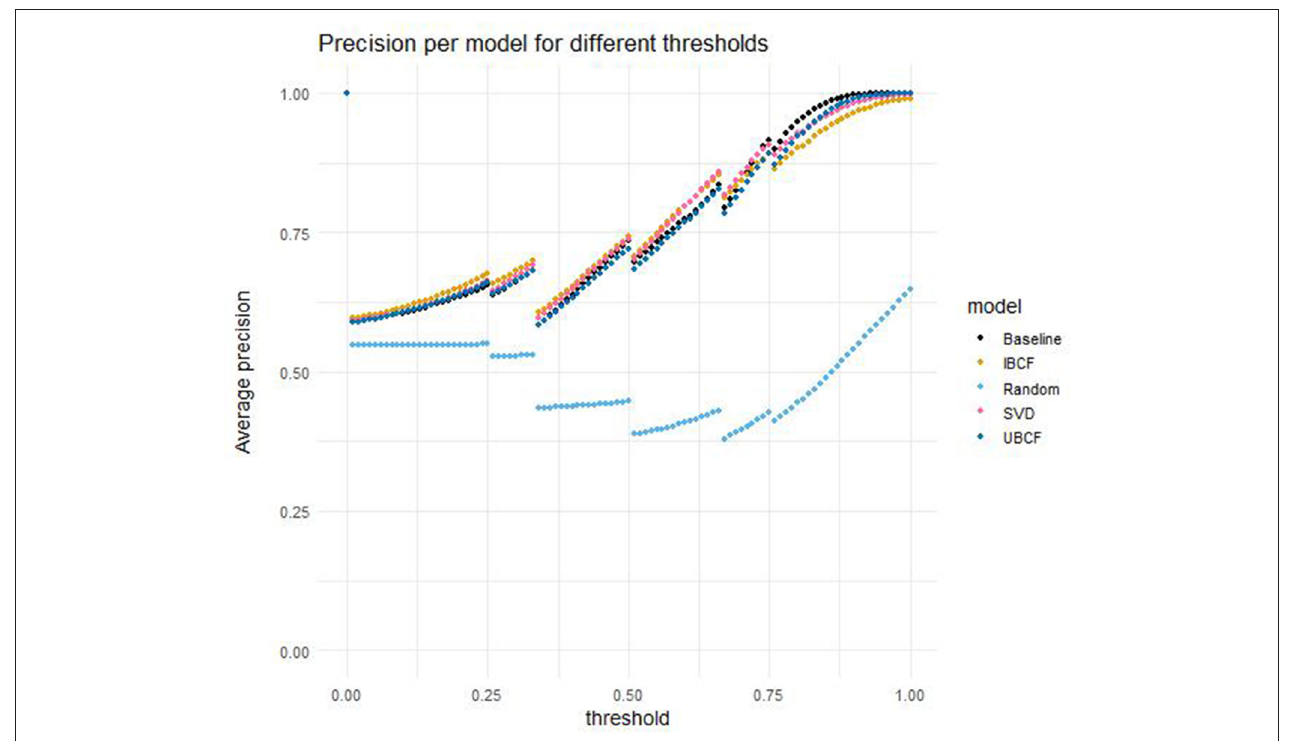
FIGURE 3 | Precision per model for different thresholds, averaged over students and cross-validation